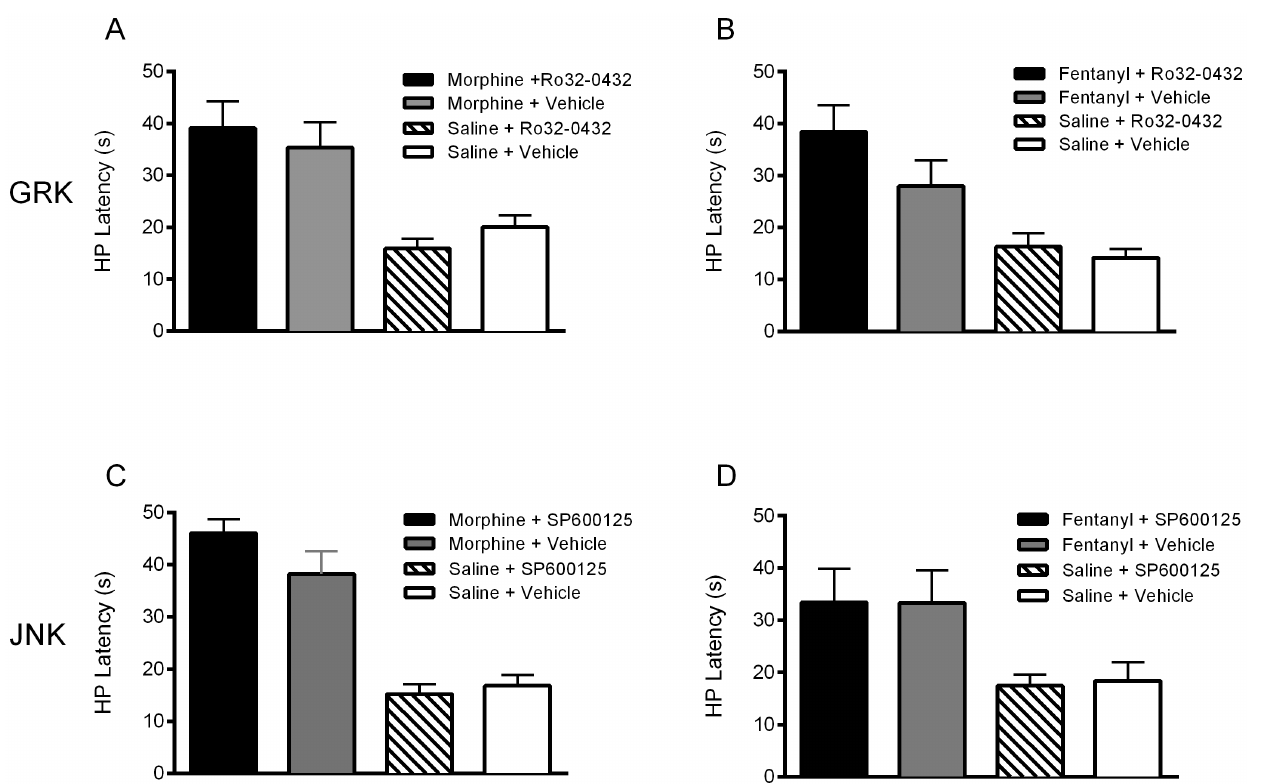
Fig. 6. The antinociceptive effects of microinjecting morphine or fentanyl into the ventrolateral PAG on Trial 1 were not altered by blocking activation of GRK/PKC or JNK. A) Microinjection of morphine produced an increase in hot plate latency compared to vehicle treated controls (F(3,32) 5 8.592, p 5 .0003) whether rats were pretreated with the GRK/PKC inhibitor Ro 32-0432 (400 ng/0.4 m l) or not (Bonferroni, t 5 0.689, n.s.). B) Likewise, fentanyl antinociception (F(3,29) 5 7.661, p 5 .0008) was not altered by pretreatment with Ro 32-0432 (t 5 1.882, n.s.). C) Microinjection of morphine produced an increase in hot plate latency compared to vehicle treated controls (F(3,29) 5 29.67, p 5 .0001) whether rats were pretreated with SP600125 (100 ng/0.4 m L) or not (t 5 1.942, n.s.). D) Likewise, fentanyl antinociception (F(3,28) 5 3.194, p 5 .041) was not altered by SP600125 pretreatment (t 5 0.008,